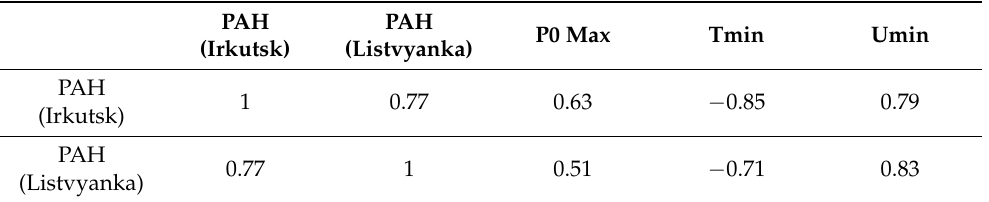
Table 3. Correlation coefficients between PAH values and meteorological parameters at the sampling stations in Irkutsk and Listvyanka (Southern Baikal region) from 2015 to 2019.